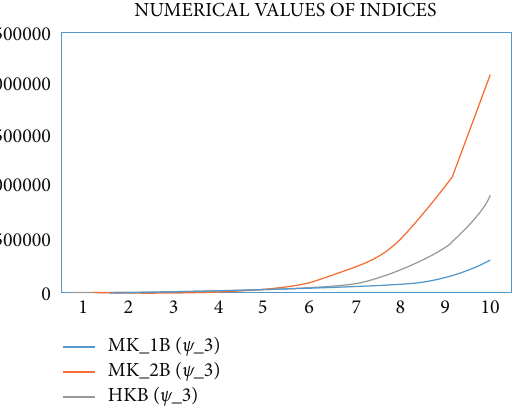
Figure 7: For TP 2.